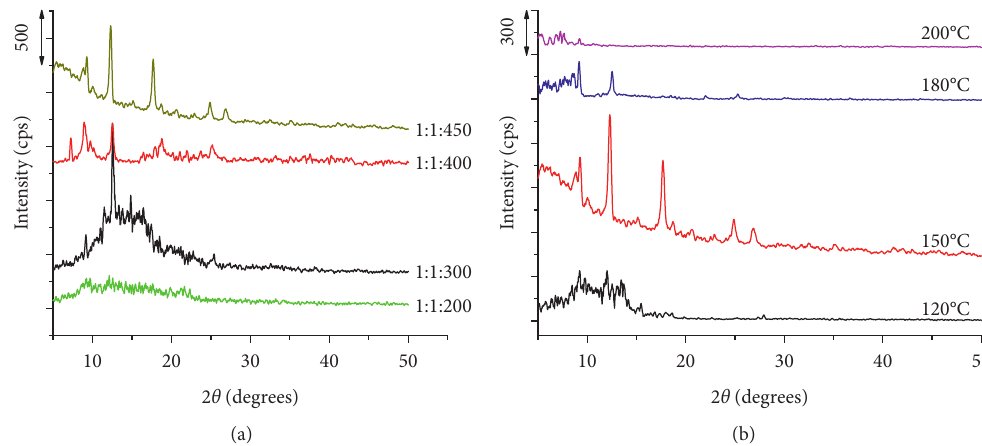
Figure 4: XRD patterns of iron (III) benzene dicarboxylate samples: (a) synthesized at 150 ° C and different solvent contents; (b) synthesized at different temperatures with a precursors/DMF molar ratio of 1:1: